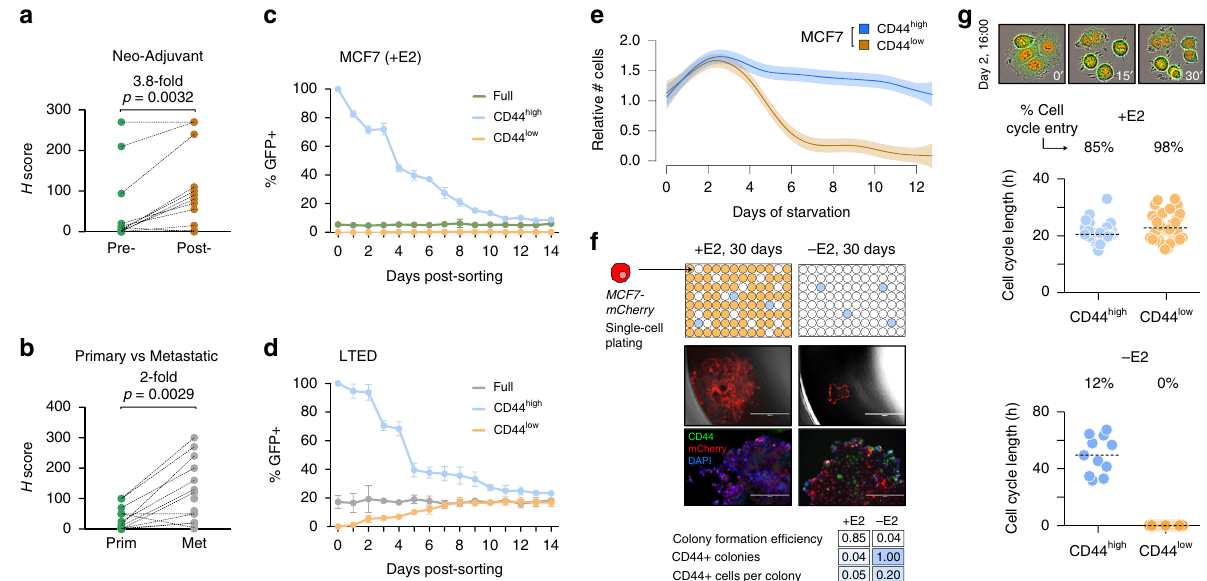
Fig. 2 Phenotypic heterogeneity of luminal breast cancer cells. a CD44 expression in neo-adjuvant AI-treated patients (pre- and post- treatment; p -value from two-tailed paired t test). b Same as ( a ), but in matched AI-treated primary-metastatic ( p -value from Wilcoxon signed-rank test). c Reconstitution experiments from sorted MCF7-CD44 GFP-high or MCF7-CD44 GFP-low cells, or the full population. d Same as ( c ), but using sorted LTED-CD44 GFP-high or LTED-CD44 GFP-low cells, or the full population. e Survival curves of MCF7-CD44 GFP-high and MCF7-CD44 GFP-low cells in oestrogen-deprived (-E2) conditions. f Single-cell plating experiments in oestrogen-supplemented ( + E2) or deprived conditions ( − E2) for 30 days. From top to the bottom: (i) schematic representation of the results; (ii) representative pictures of single wells after 30 days (scale bar = 1000 μ m); (iii) immuno fl uorescence staining highlighting CD44 expression (scale bar = 200 μ m); (iv) summary statistics. g Cell-cycle dynamics of MCF7-CD44 GFP-high and MCF7-CD44 GFP-low cells inferred from time-lapse imaging. The length of the cell cycle and percentage of cell entering the cell cycle are indicated for both oestrogen-supplemented ( + E2; top) and deprived conditions ( − E2; (Fig. 2d; Supplementary Fig. 3g). When MCF7 were challenged About 10,000 single cells in E2-supplemented condition were pro fi led (CD44 GFP-high and CD44 GFP-low in equal proportions; Fig. 3a; in the remainder of the text, these two sorted sub- populations will be referred to as CD44 high and CD44 low ).